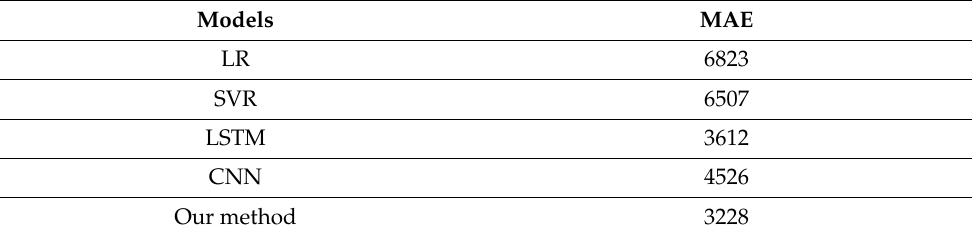
Table 2. Comparison of our model with other models in terms of MAE; lower MAE values indicate better